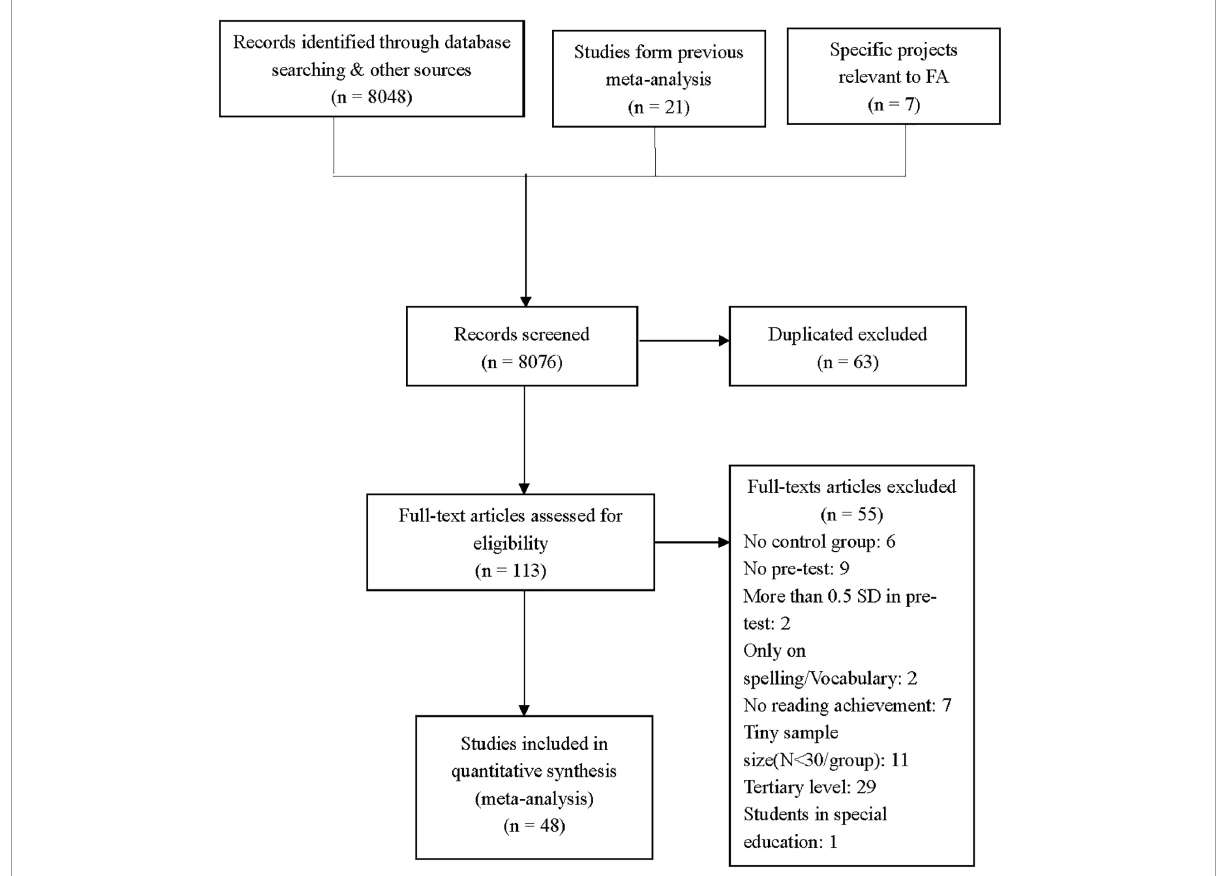
FIGURE1 PRIMA flow chart (Moher et al.,